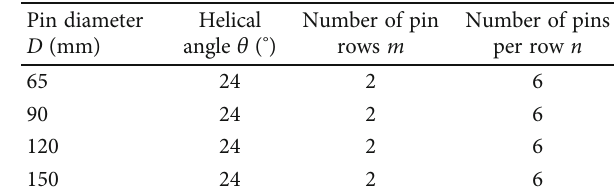
Table 1: Screw speci fi cation parameters.